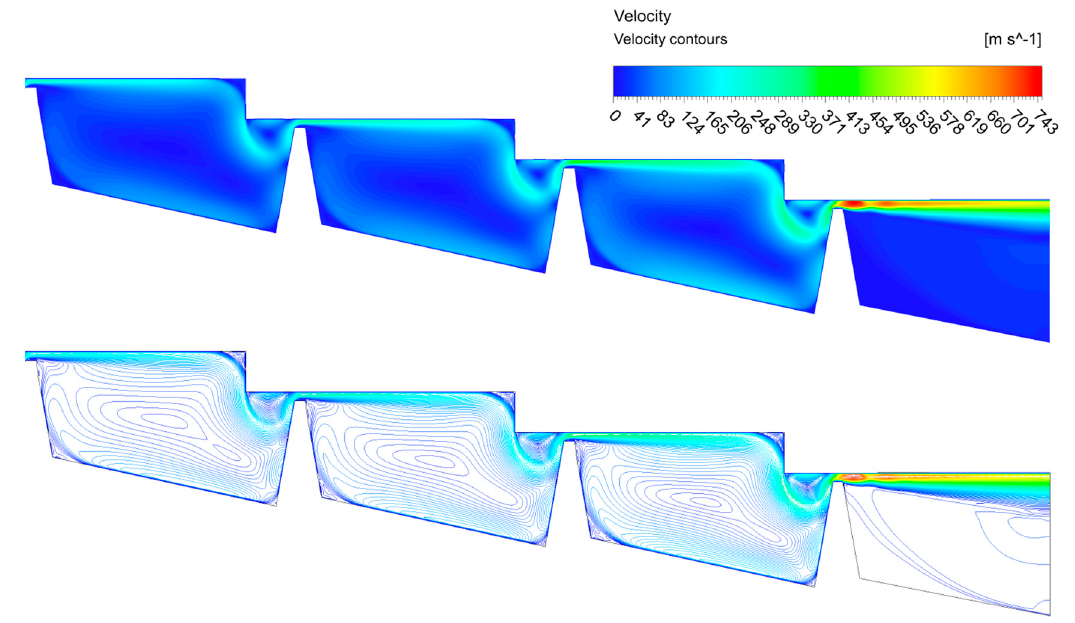
Figure 11. Velocity contours inside the stepped labyrinth